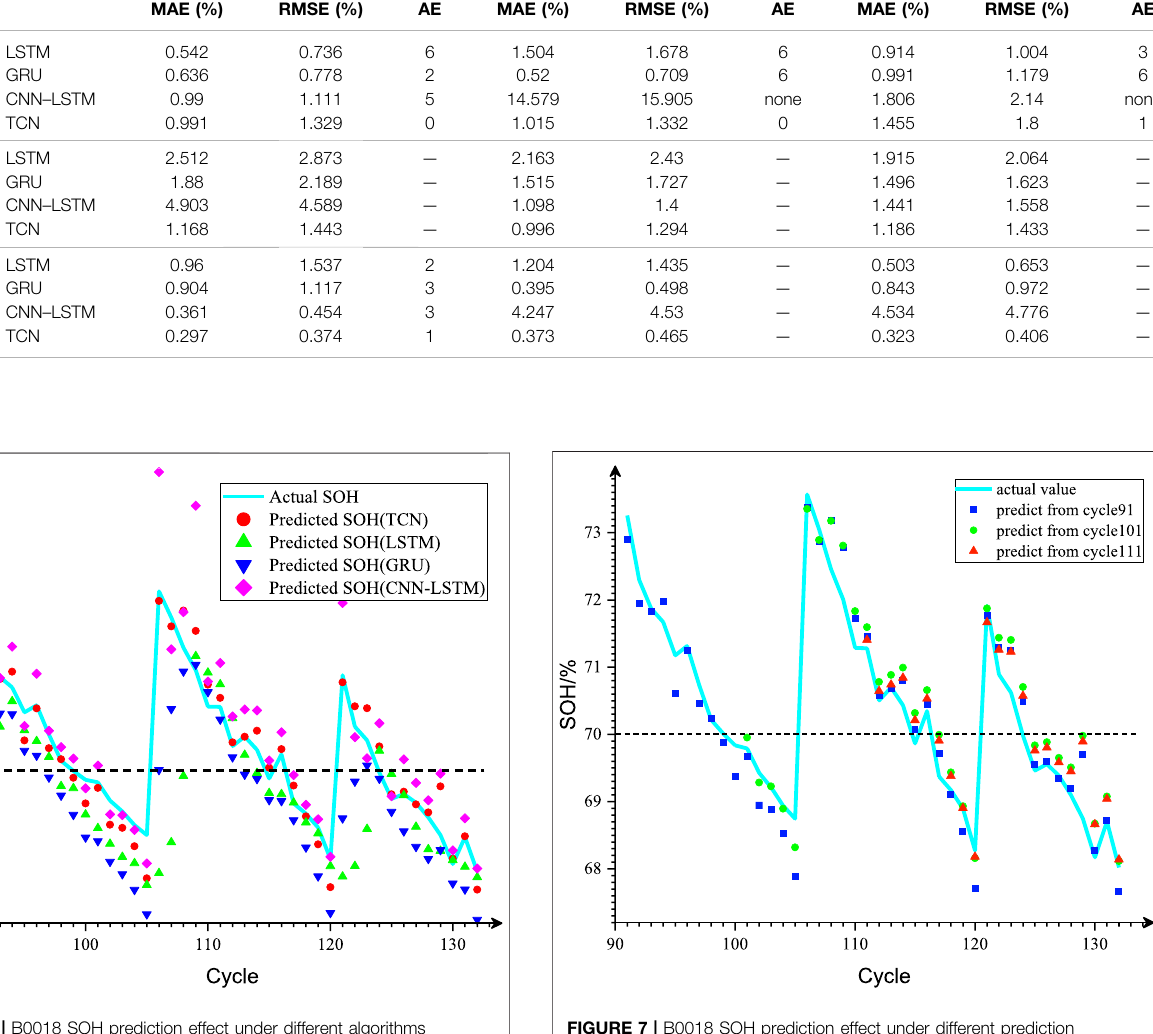
FIGURE 6 | B0018 SOH prediction effect under different algorithms (starting point is set to